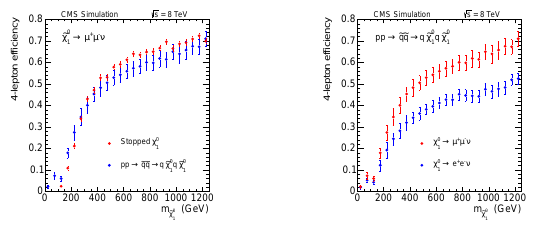
F igure 8. Left : e ffi ciency of this analysis for neutralinos de- caying in rest (red points), overlaid with LRPV e ffi ciency from Fig. 7. Right : e ffi ciency profiles for electrons and muons.